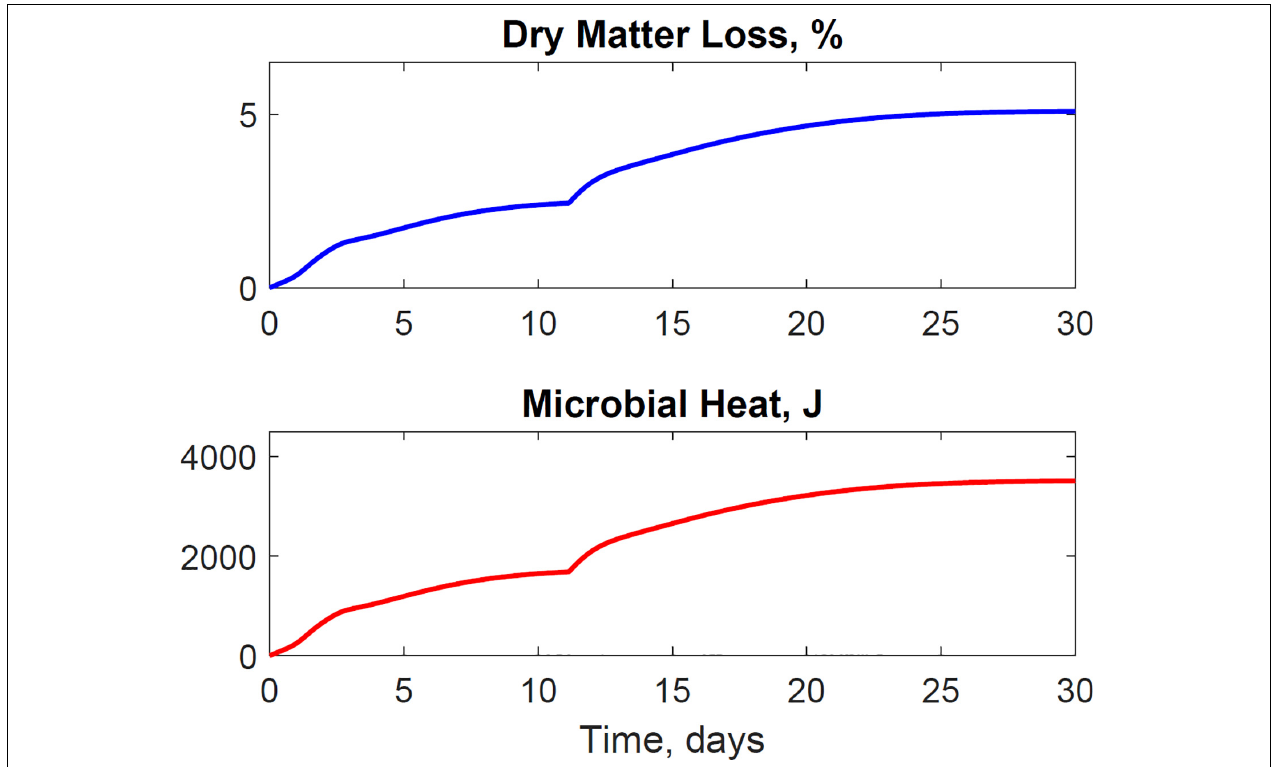
FIGURE 7 | The model illustrates the dynamics of dry matter loss and microbial heat evolution. The sigmoidal microbial heat governs the temperature rise in the system. Microbial activity and heat itself are dynamically controlled for the system temperature.